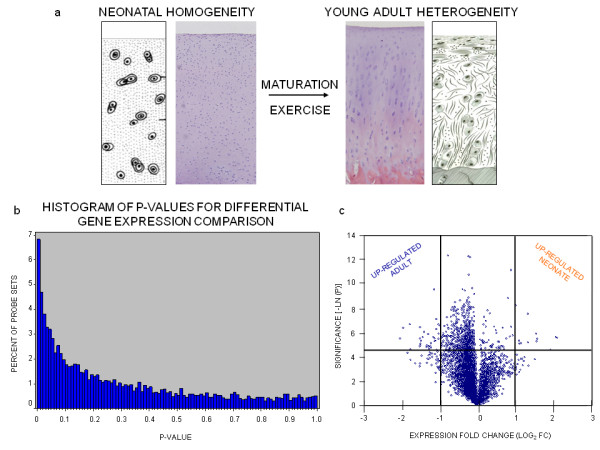
cDNA microarray transcriptional profiling indicates differential gene expression between neonatal and adult articular cartilage. (a) Histomorphometric comparison of isotropic articular cartilage structure in the equine neonate and the anisotropic structure in adults. (b) A p-value histogram of differentially expressed transcripts from the 9,367 element equine-specific cDNA microarray demonstrates that just under 7% of the clones had significance at p < 0.01. (c) A volcano plot of the neonatal versus adult comparison; points above the horizontal black line are transcripts demonstrating differential expression with a significance of p < 0.01. The two vertical black lines correspond to 2-fold up- and down-regulation. Degree of statistical significance is displayed along the vertical axis and expression fold change along the horizontal axis.